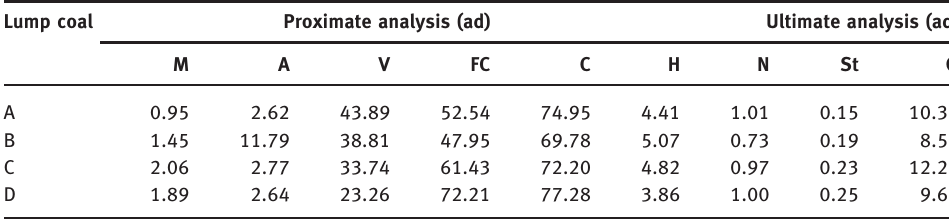
Table 1: Proximate analysis and ultimate analysis of the coal samples, mass %. Lump